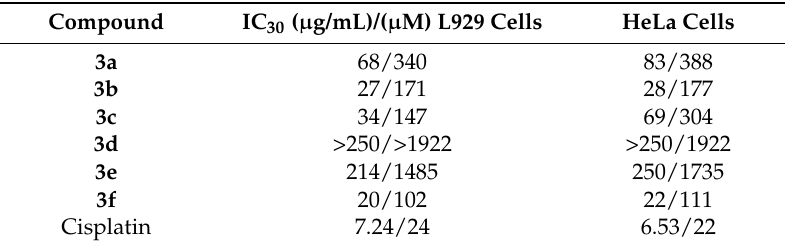
Table 5. Cytotoxic activity